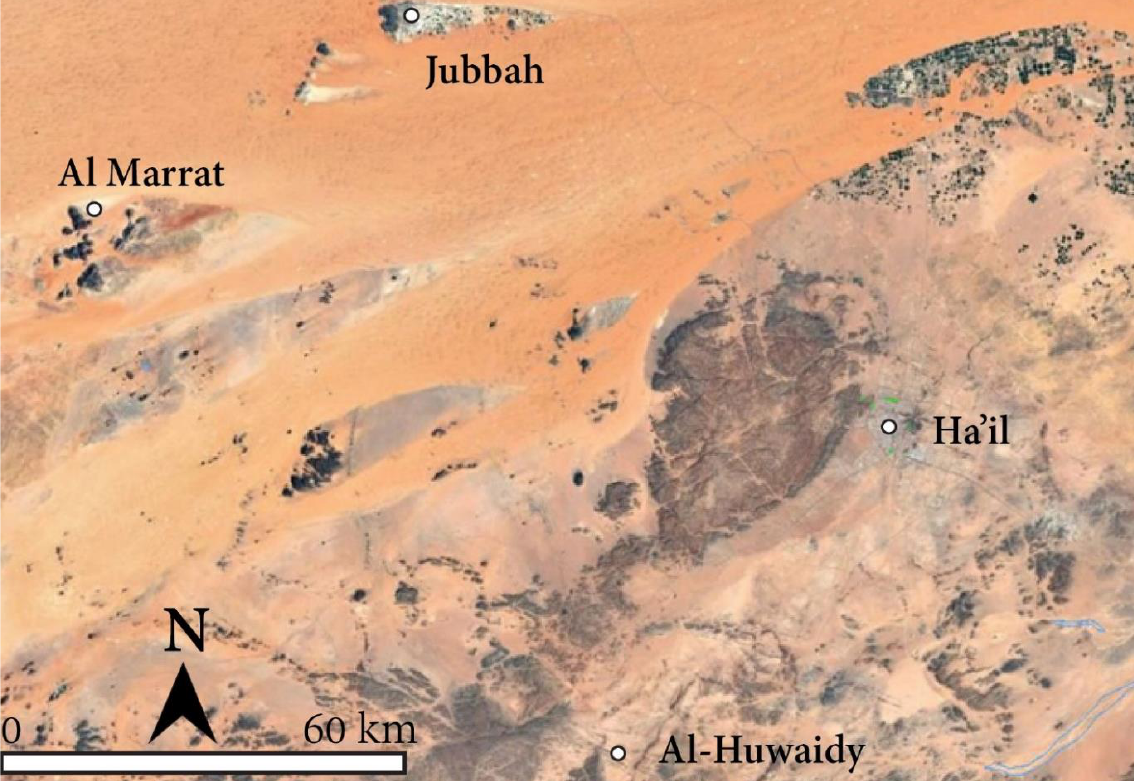
Figure 2: General view of Ha’il region landscape from Google Earth and the location of Al-Huwaidy site in the volcanic area and Jubbah and Al Marrat sites in sandstone, sand dunes